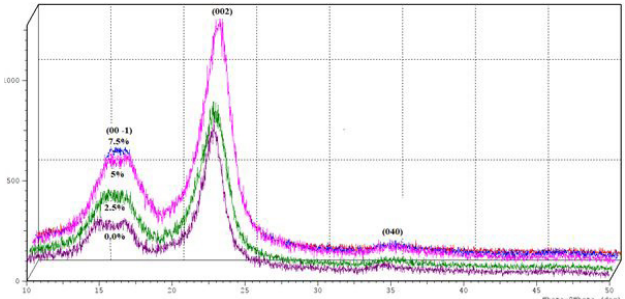
Figure 6. Diffractograms of untreated Curauá fibres and treated with different NaOH concentration (at immersion times of 4h).